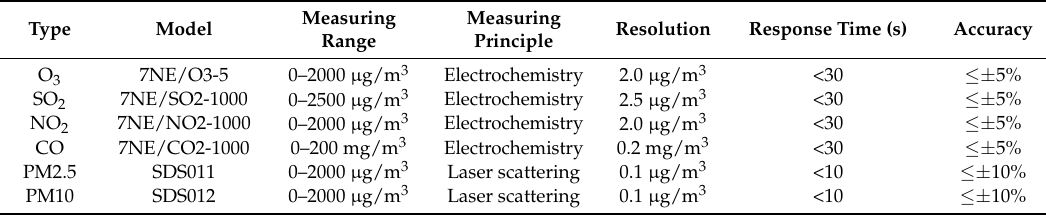
Table 1. The atmospheric sensors’ specific parameter characteristics (model, measuring range, measuring principle, resolution, response time, accuracy) used in the system. PM = particulate